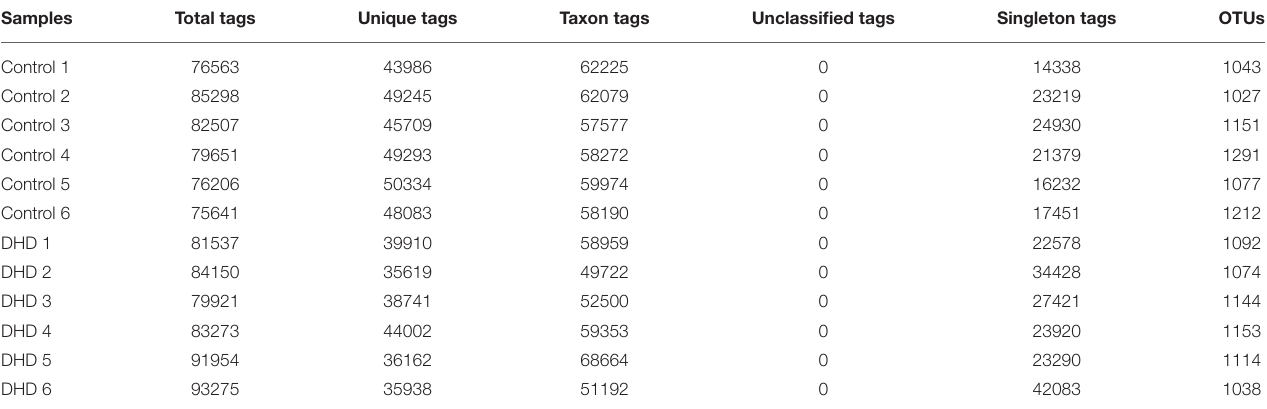
TABLE 2 | Tags and OTU quantity statistics in DHD and healthy calves.